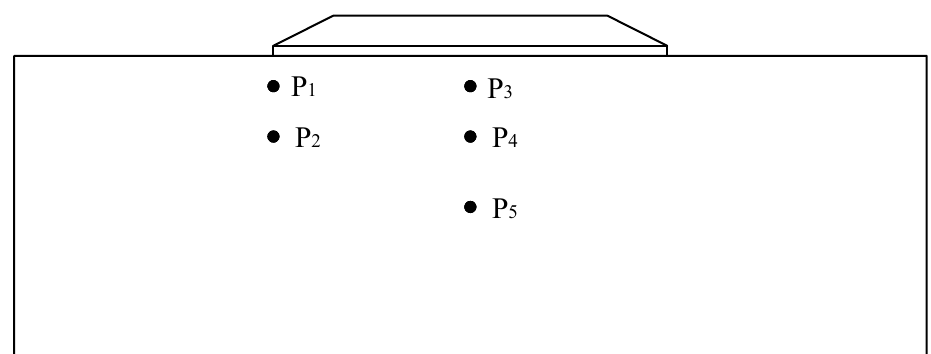
Figure 10. Observation point locations for analysis of dynamic excess pore water pressure. The time histories of dynamic excess pore water pressure in natural foundation, foundation reinforced with isometric gravel piles, and foundation reinforced with subarea long-short gravel piles, in the deeply deposited saturated liquefiable soil during an earthquake, are shown in Figure 11.